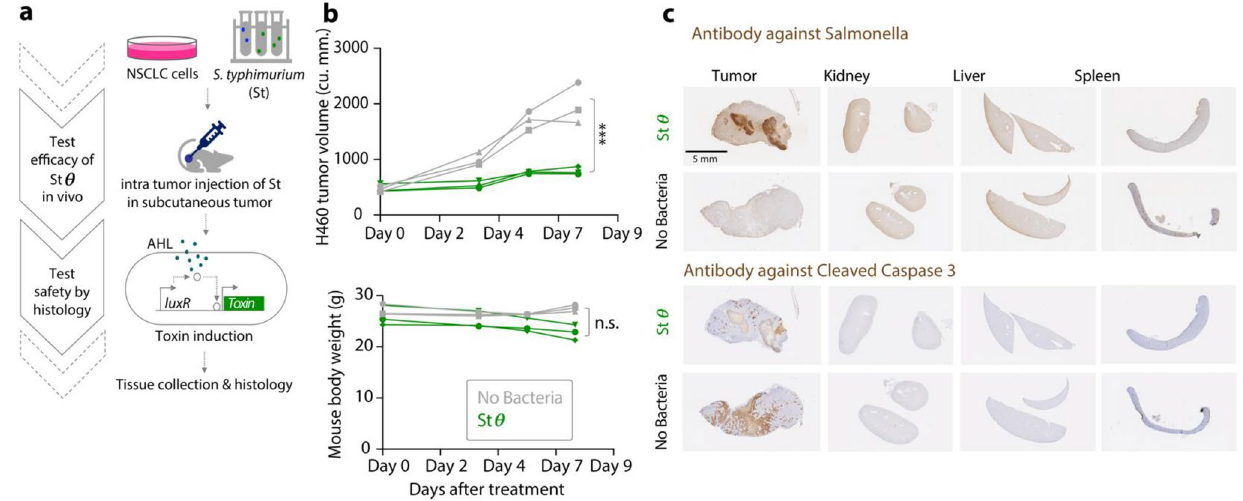
Figure 2. Testing the efficacy of bacterial toxins in NSCLC in vivo. ( a ) Schematic of the second part of the pipeline to test the efficacy and safety of bacterial toxins via intratumoral delivery ( b ) (top) Response of H460 subcutaneous tumors in NSG mice to intratumor delivery of live S. typhimurium secreting θ toxin upon induction with AHL injection. Treatment began once tumors reached ~ 500 cu.mm., using 40 uL of live bacteria in sterile 1 × DPBS (vehicle) with concentration 4.5 × 10 8 CFU/mL (OD 1), twice a week, (bottom) body weight of mice including tumors’ weight, significant change (*** = p < 0.001, n.s. = not significant) was determined by two-way repeated Anova (n = 3). ( c ) Representative histology images of formalin-fixed, paraffin-embedded tumors and peripheral organs stained for S. typhimurium serotype ‘O’ specific antibody and cleaved Caspase 3 with or without bacteria